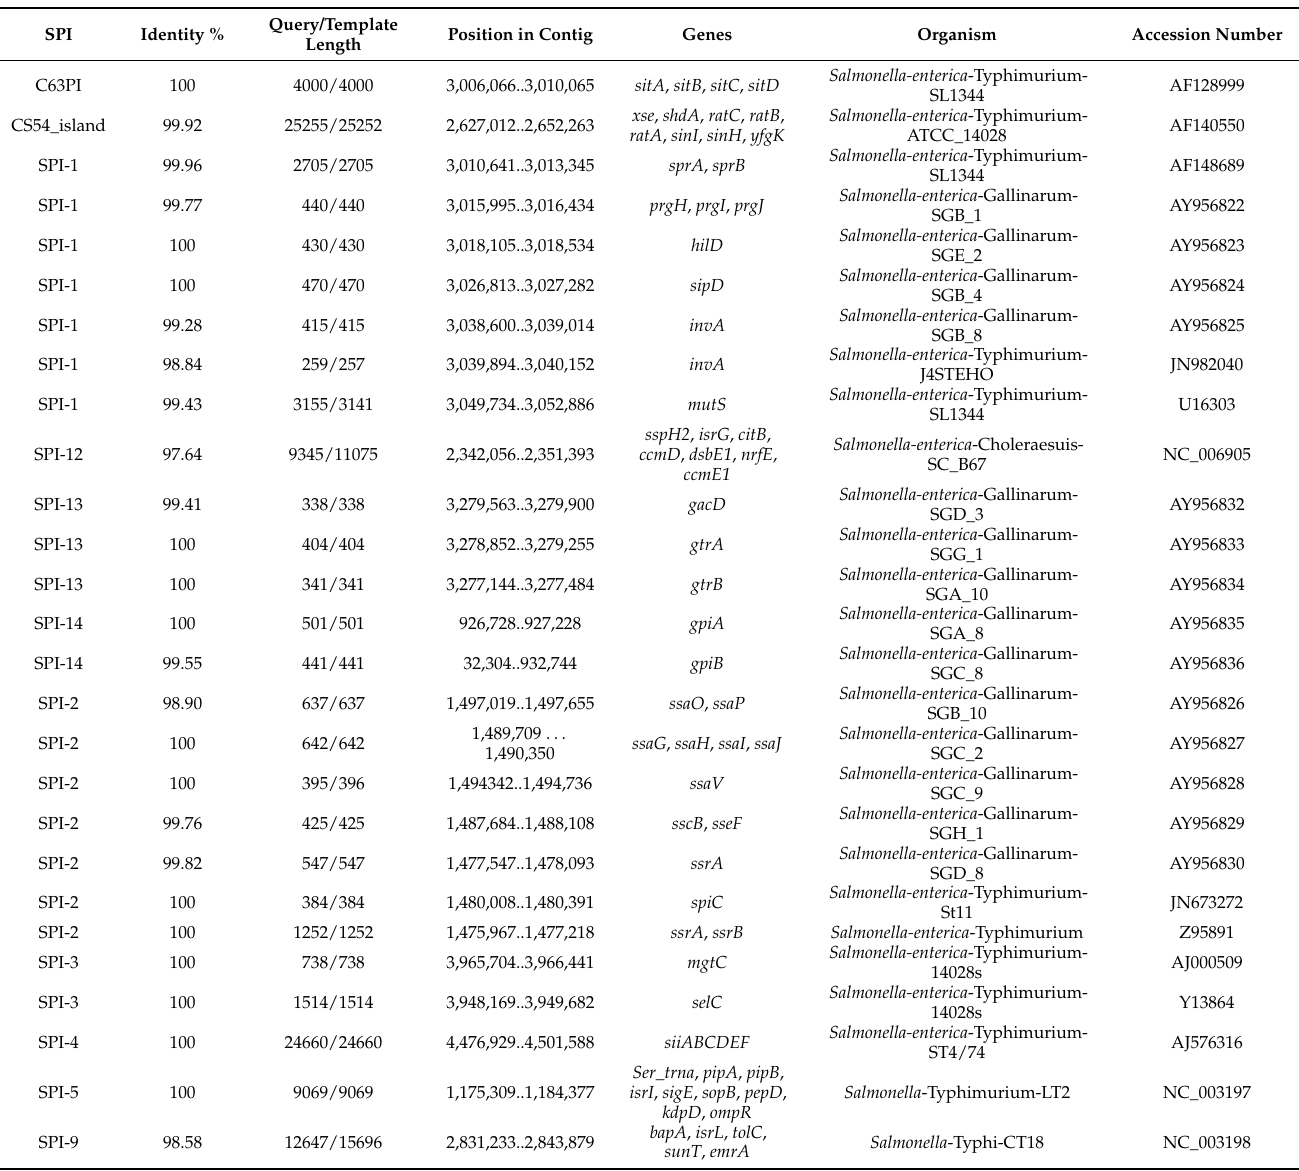
Table 1. Salmonella Pathogenicity Islands (SPIs) detected in the genome of Salmonella enterica subsp. enterica Typhimurium isolated from human milk ( S . Typhimurium 69M) and their refer- ences in